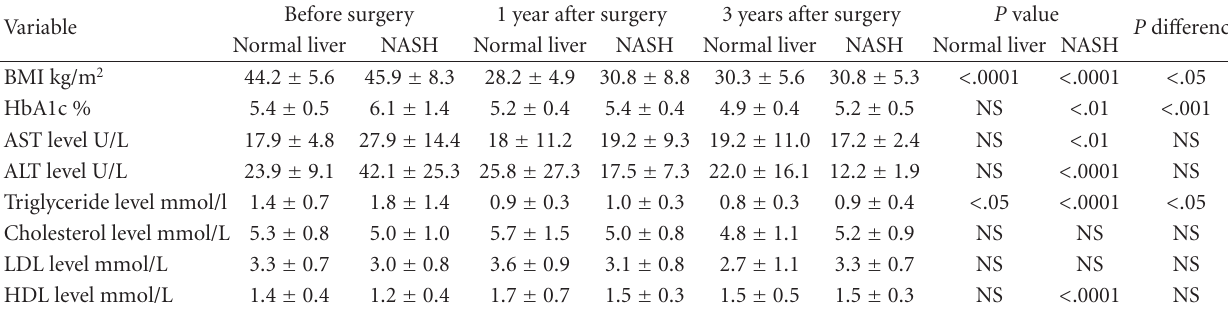
Table 3: Separate consideration of clinical and biological data at 1- and 3-year followup for patients with NASH and normal liver histology.